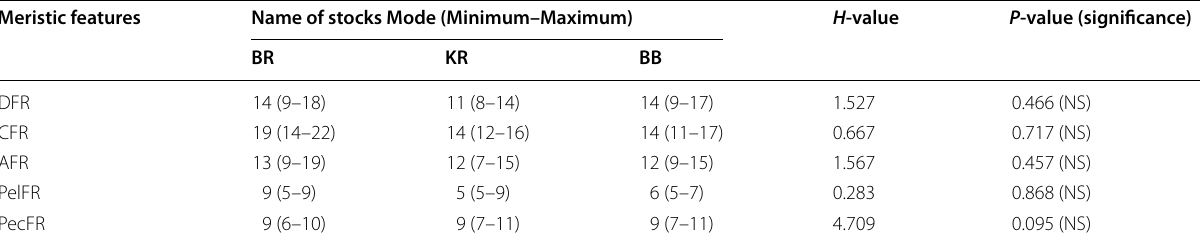
H-value Kruskal Wallis Test, NS Non-significant, BR : Bhairab River, KR Kopotakkho River, BB Baluhar Baor